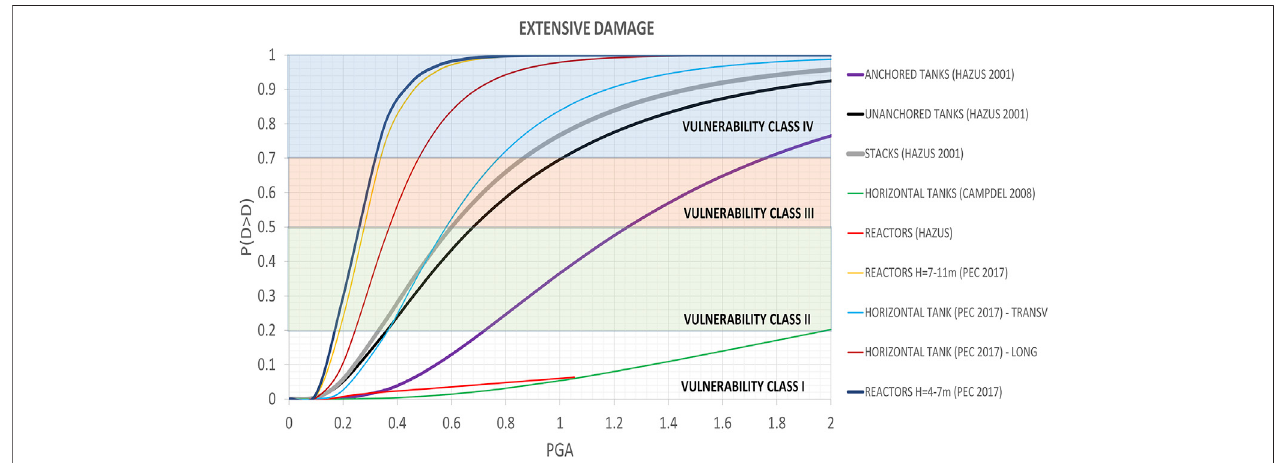
FIGURE 3 | Fragility functions of plant equipment.